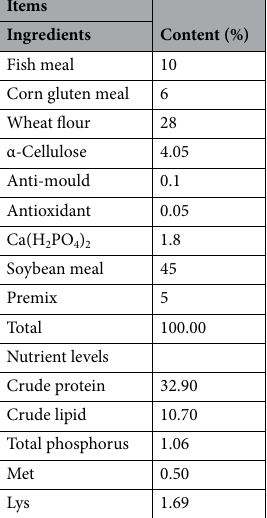
Species Moisture Crude protein Crude lipid